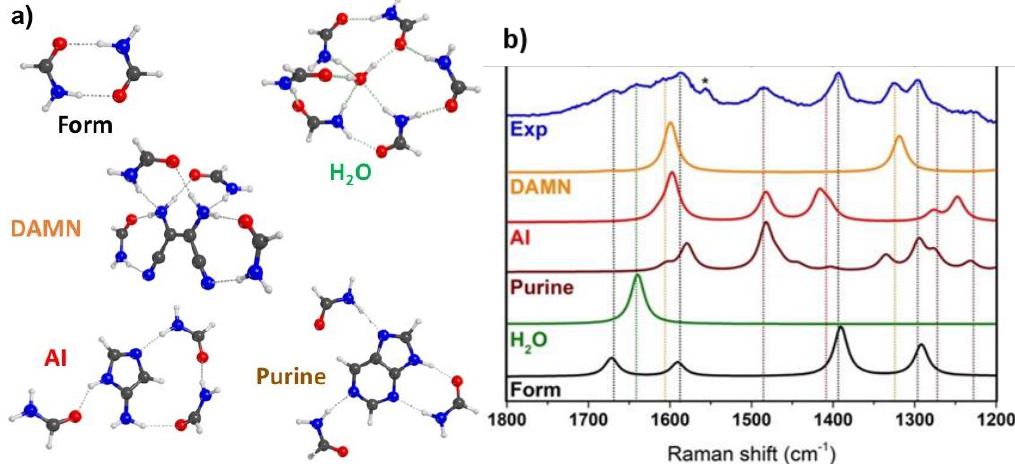
Figure 3. ( a ) Optimized B3LYP-D3 / TZVP structures of the formamide micro-solvated species: Form (formamide), water (H 2 O), diaminomaleonitrile (DAMN), 5-aminoimidazole (AI) and Purine (Purine). ( b ) Experimental UV-Raman ( λ = 266 nm) spectrum of formamide at 160 ◦ C on amorphous SiO 2 (Aerosil OX50, calcined at 450 ◦ C) after 12 h of reaction (Exp, blue curve) compared to the B3LYP-D3 / TZVP anharmonic Raman spectra for DAMN (orange curve), AI (red curve), Purine (brown curve), H 2 O (green curve) and Form (black curve). The asterisk (*) marks the feature associated to atmospheric O 2 , as present in the optical path of the instrument.